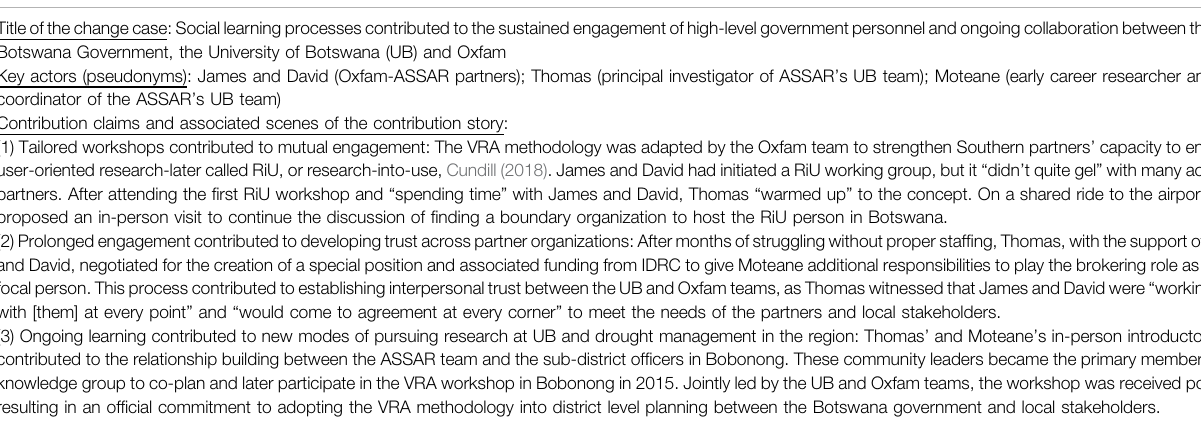
TABLE 3 | Social learning contributions to the ASSAR Botswana